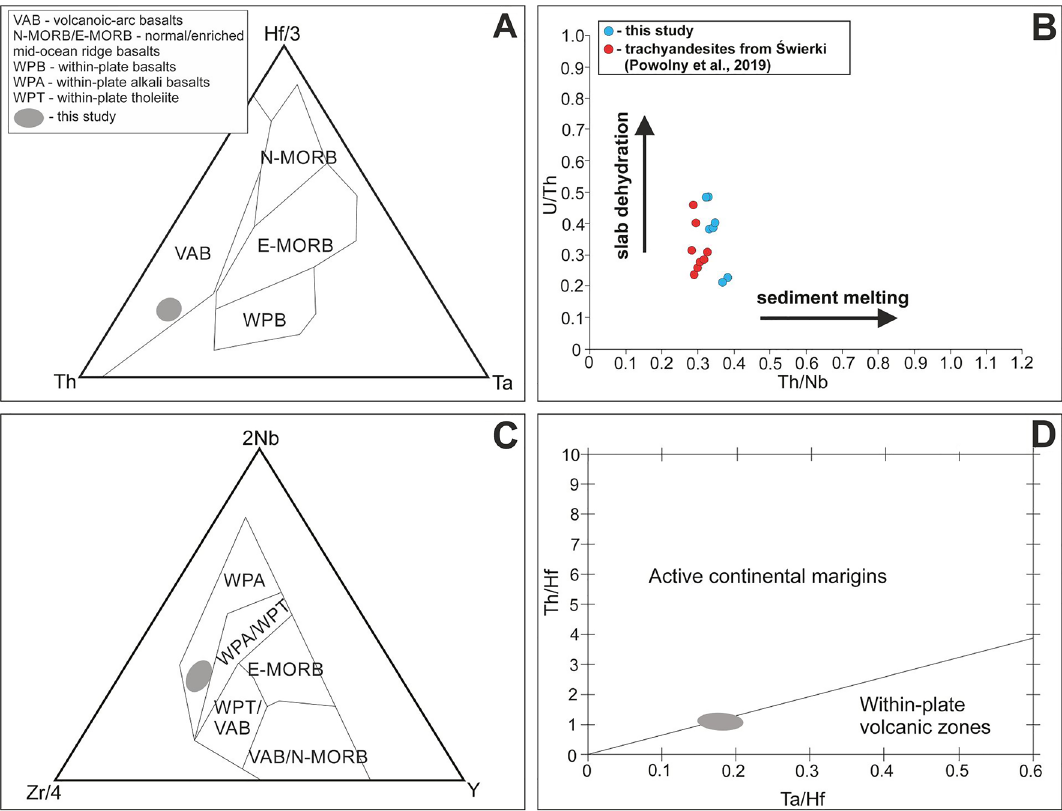
Figure 15 . Examples of tectono-magmatic discrimination diagrams for trachyandesites from Głuszyca. ( A ) Th–Ta–Hf/3 discrimination plot 70 showing volcanic-arc basalts affinity (VAB); ( B ) U/Th versus Th/Nb plot 73 , where the samples follow slab dehydration rather than sediment melting trend (both mechanisms can account for the presence of subduction-related signatures); note the position of trachyandesites from Świerki exposure in the ISB (ca. 3 km SW of Głuszyca exposure) has also been included in order to better visualize particular trends 21 ; ( C ) 2Nb–Zr/4–Y discrimination plot 71 showing within-plate affinity (WPA); ( D ) Ta/Hf–Th/Hf diagram 72 where the samples straddle the boundary between arc- and within plate-related fields.